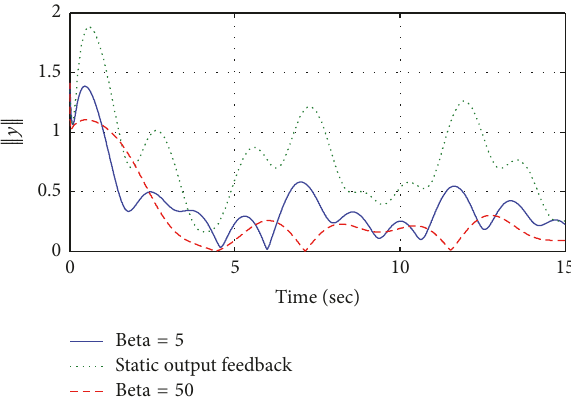
Figure 1: System states of the proposed method with 𝛽 = 50 . Figure 2: Responses of ‖ y (𝑡)‖ of the three cases.